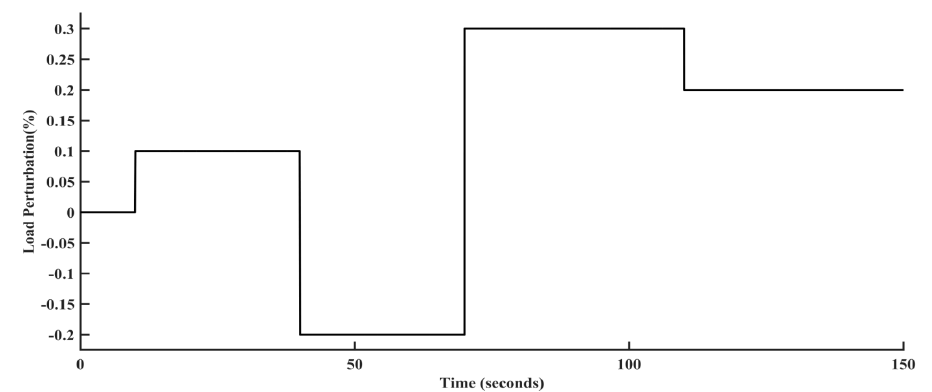
Figure 20. A random load disturbance.